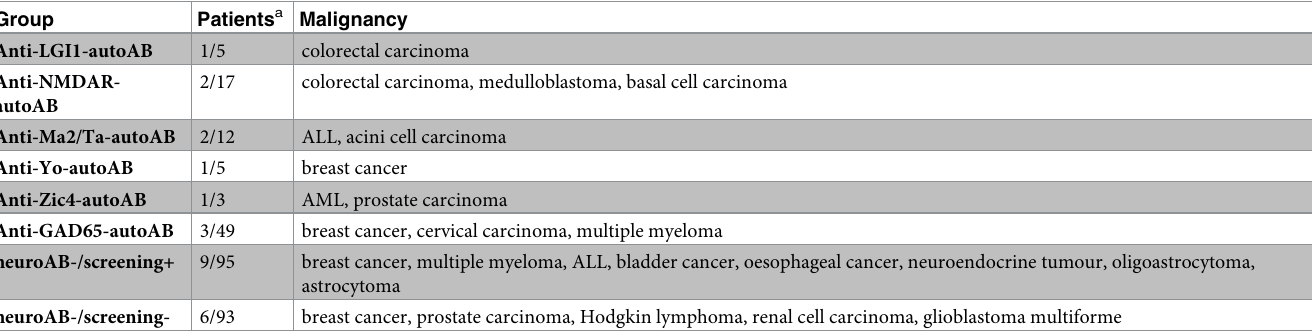
Table 2. Distribution of malignancies in TAOS patients.